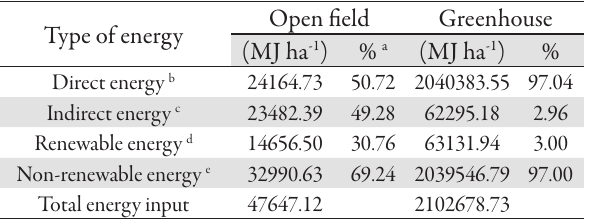
Tab. 5. Input contributions (%) in tomato production in open